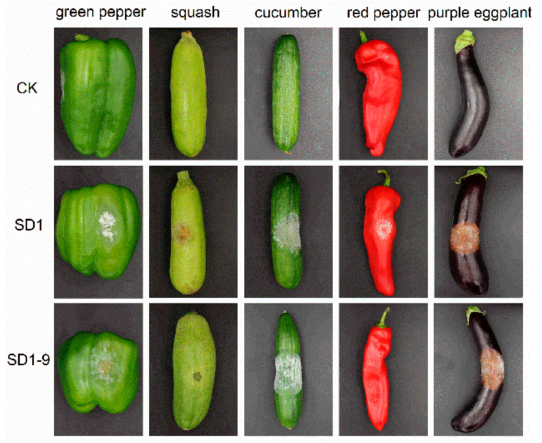
Figure 2. Pathogenic phenotype of P. capsici on di ff erent